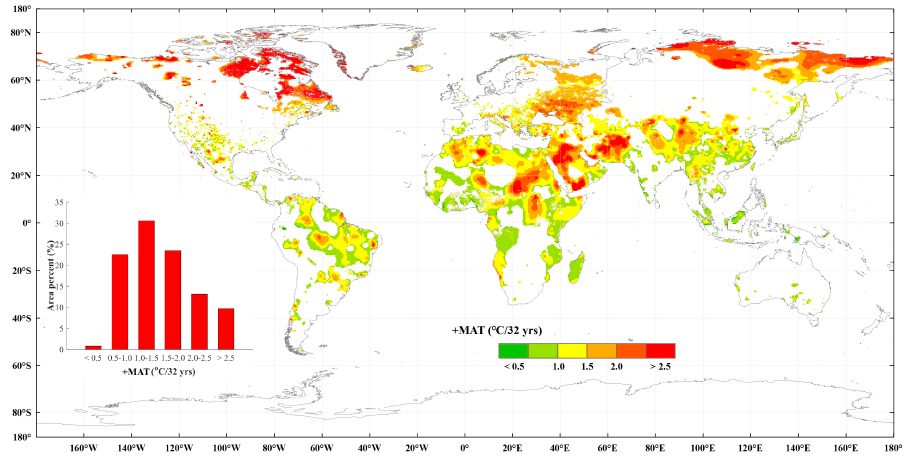
Figure 1. Increment of mean annual temperature (+MAT) from 1982–2013 at the global scale (increments significant at p < 0.01 only). Table 1. Statistics of area, area percent, +MAT, and +MAT at the 90th percentile for various vegetation biomes at the global scale.